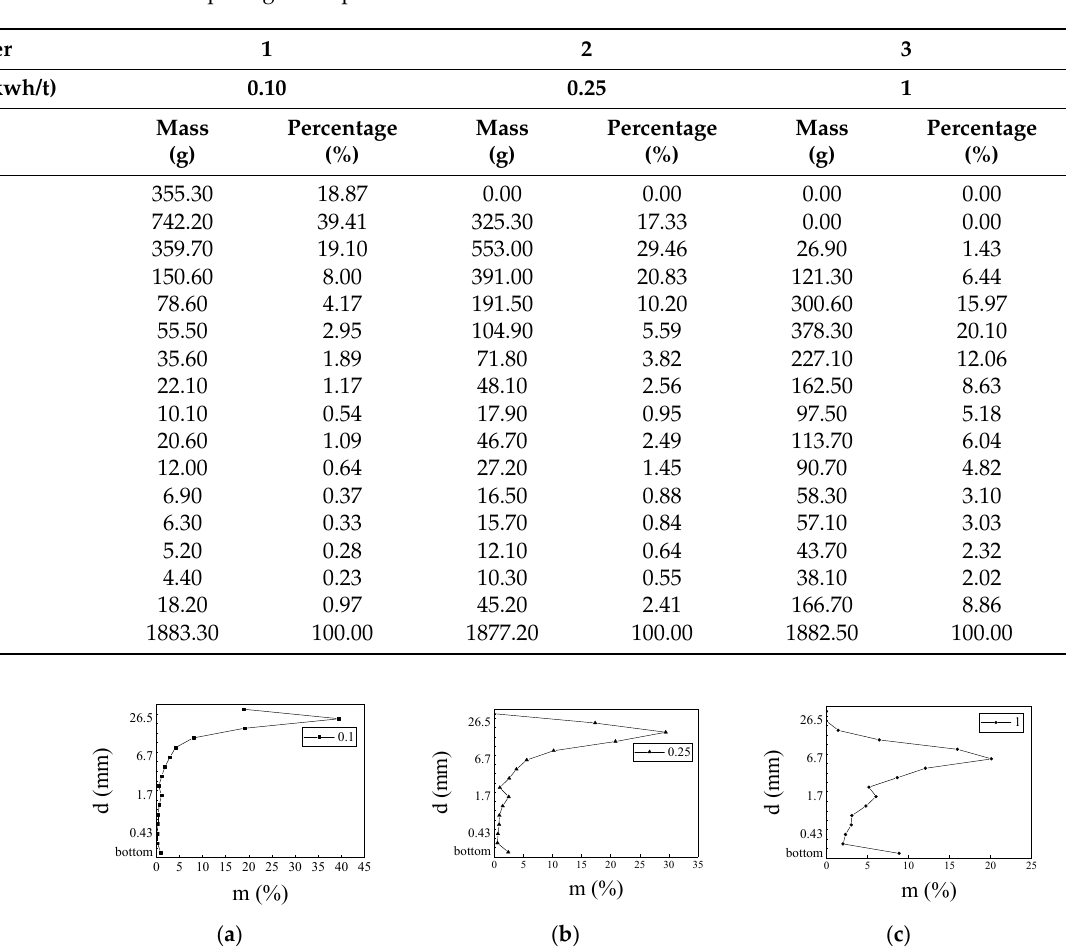
Table 2. Drop weight test particle size distribution.